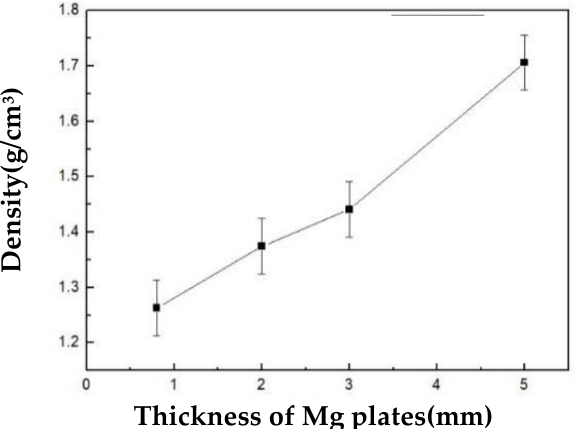
Figure 13. Density of the sandwiched magnesium matrix syntactic foams with different end plate thicknesses.